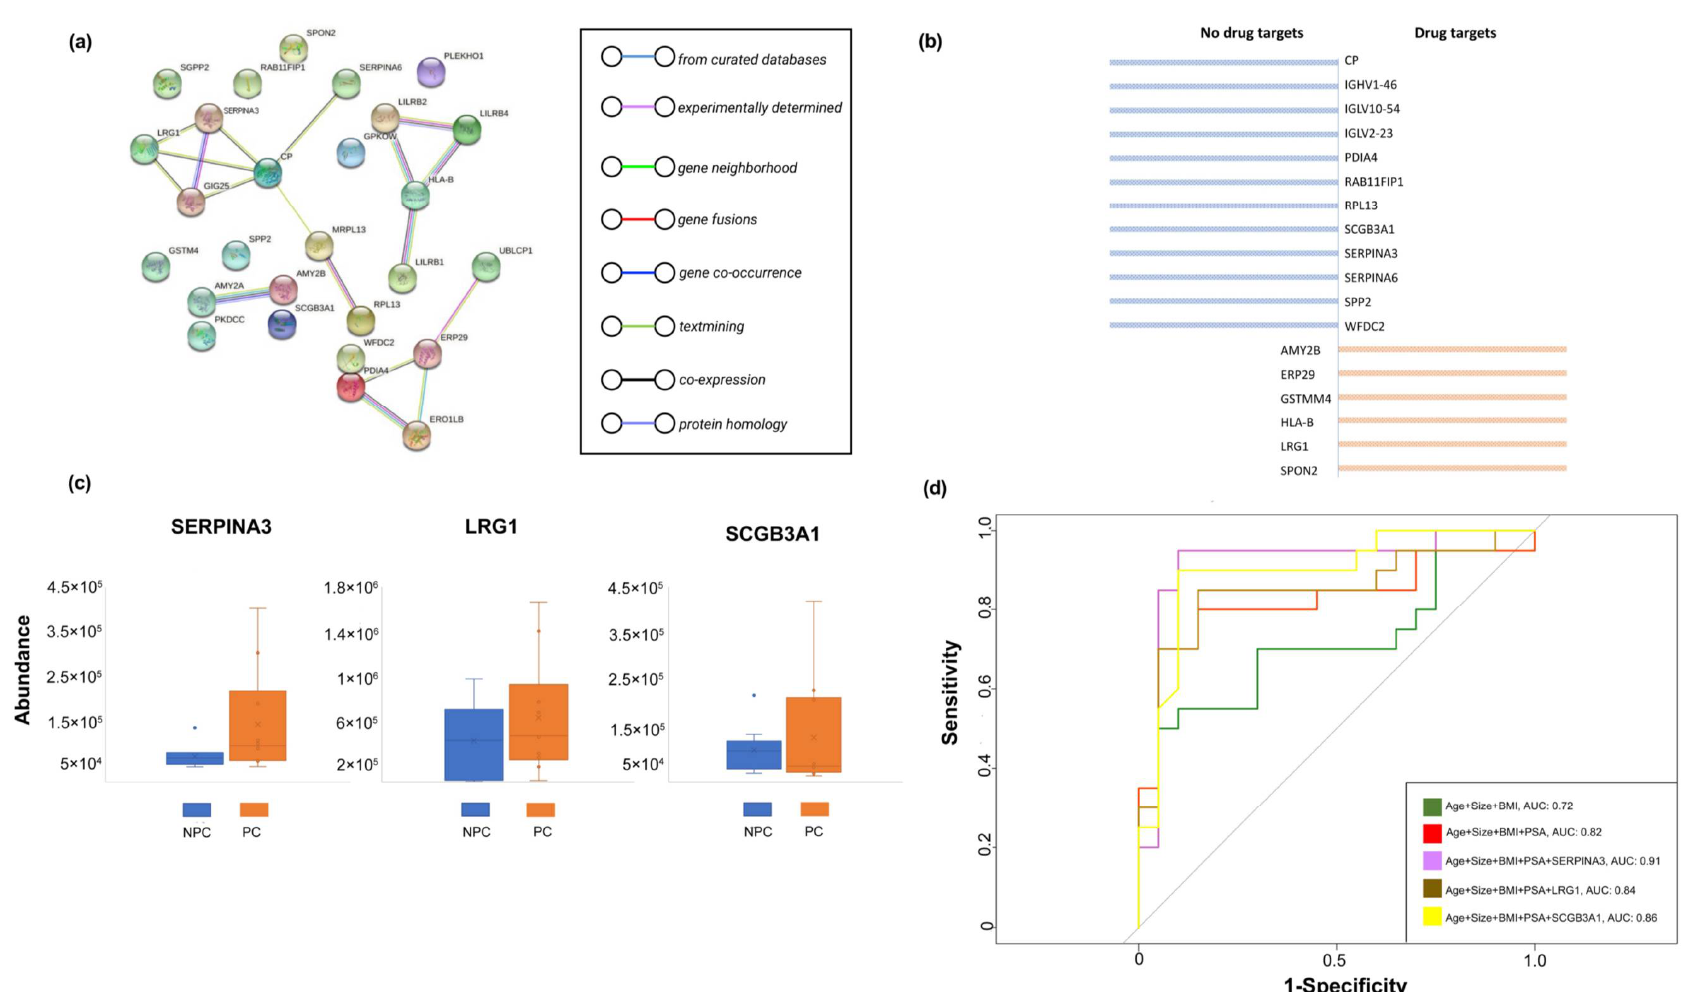
Figure 5. Post analyses for the Differentiated Urinary EV Proteins. ( a ) Results of the STRING interaction analysis (PPI enrichment); ( b ) Established druggable targets from the identified EV proteins. ( c ) Comparison of consistently upregulated EV proteins between prostate cancer cases and non-prostate cancer controls based on the validation cohort. ( d ) ROC curves and the corresponding AUCs for the components of clinical information and identified EV proteins.